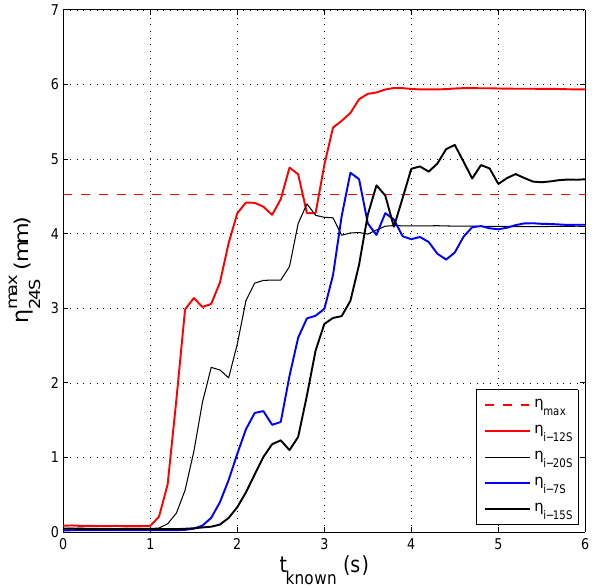
Fig. 10. Predicted maximum surface elevation at gauge 24S, using as input partial time series of length t known ; horizontal dashed line represents the reference experimental result at gauge